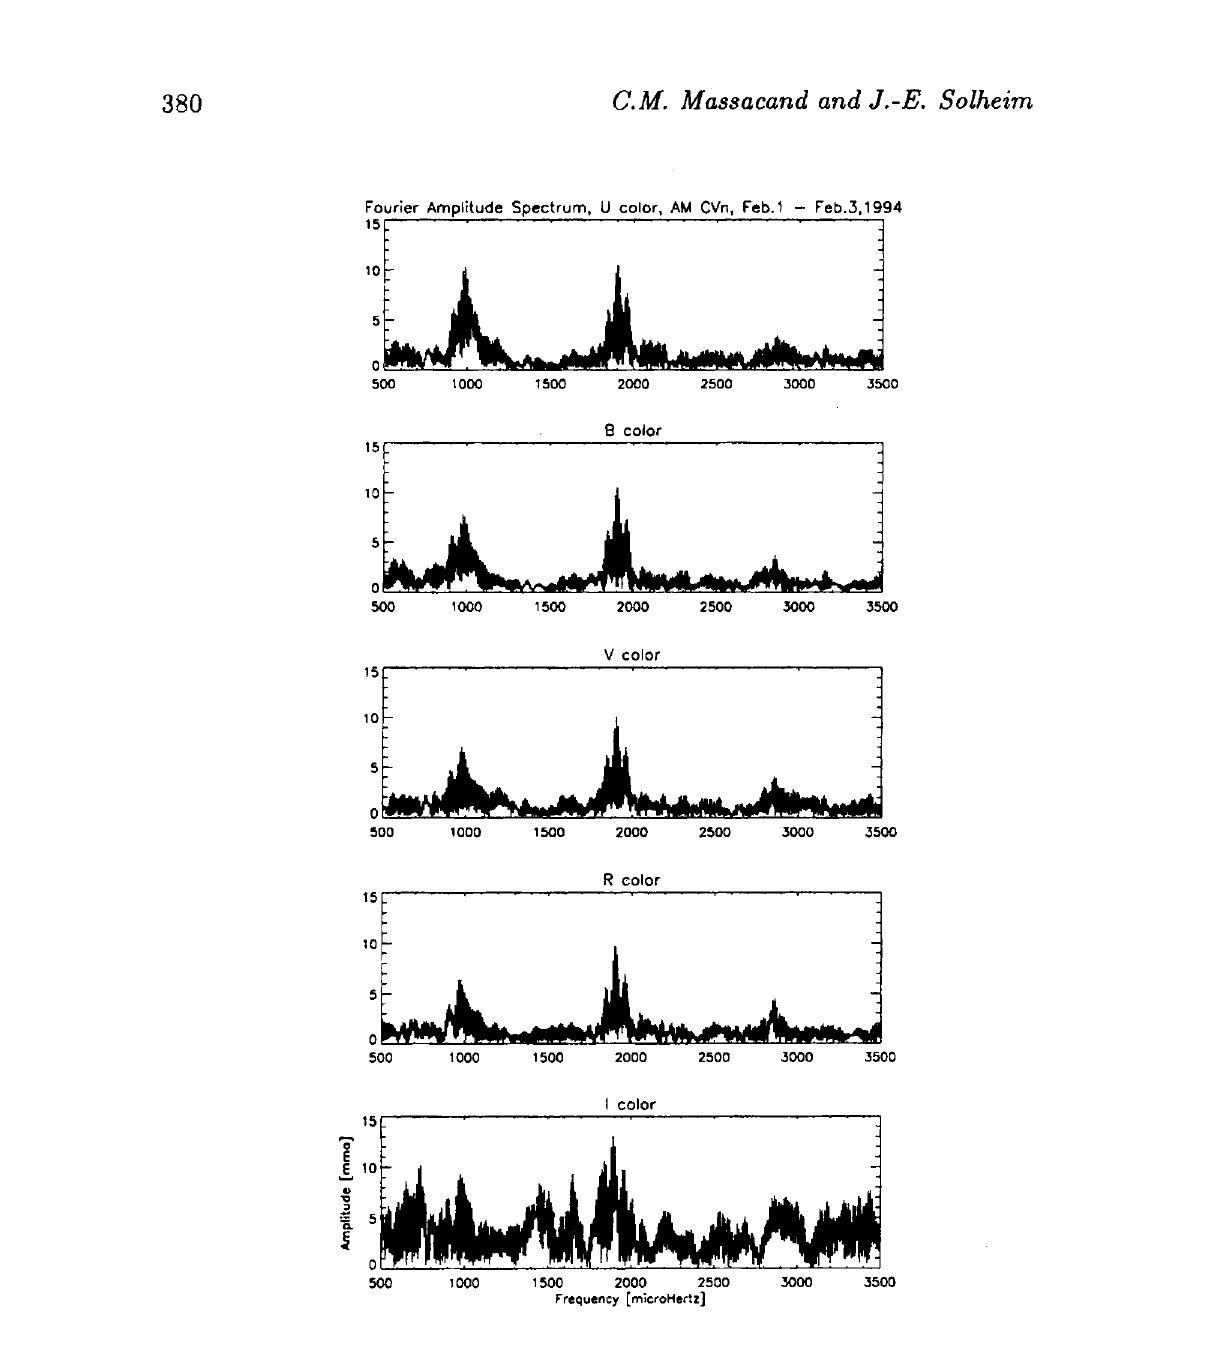
Fig. 2. Amplitude spectra for the U B V RI light curves of AM CVn observed with NOT during three nights in February 1994. The plots show the three main peaks at 988.7 //Hz (1011.4 s), at 1902.6 //Hz (525.6 s) and at 2853.9 //Hz (350.4